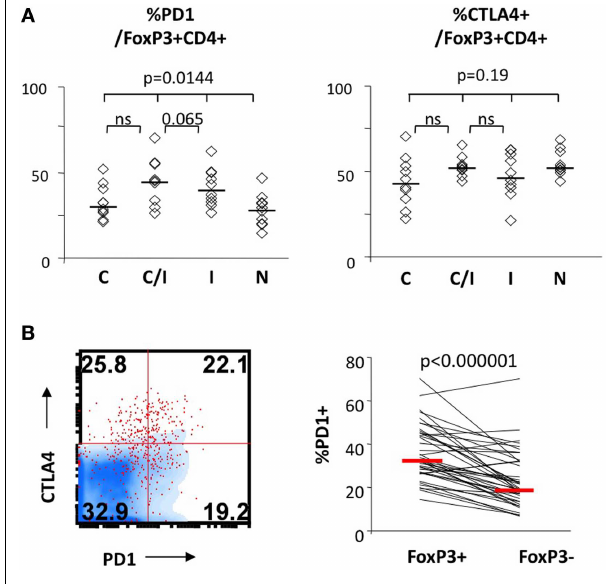
Treg FREQUENCY OR IMMUNE INHIBITORY RECEPTOR EXPRESSION LEVELS ON T CELLS Effector T cell responses to HCV NS3, HIV Gag, and